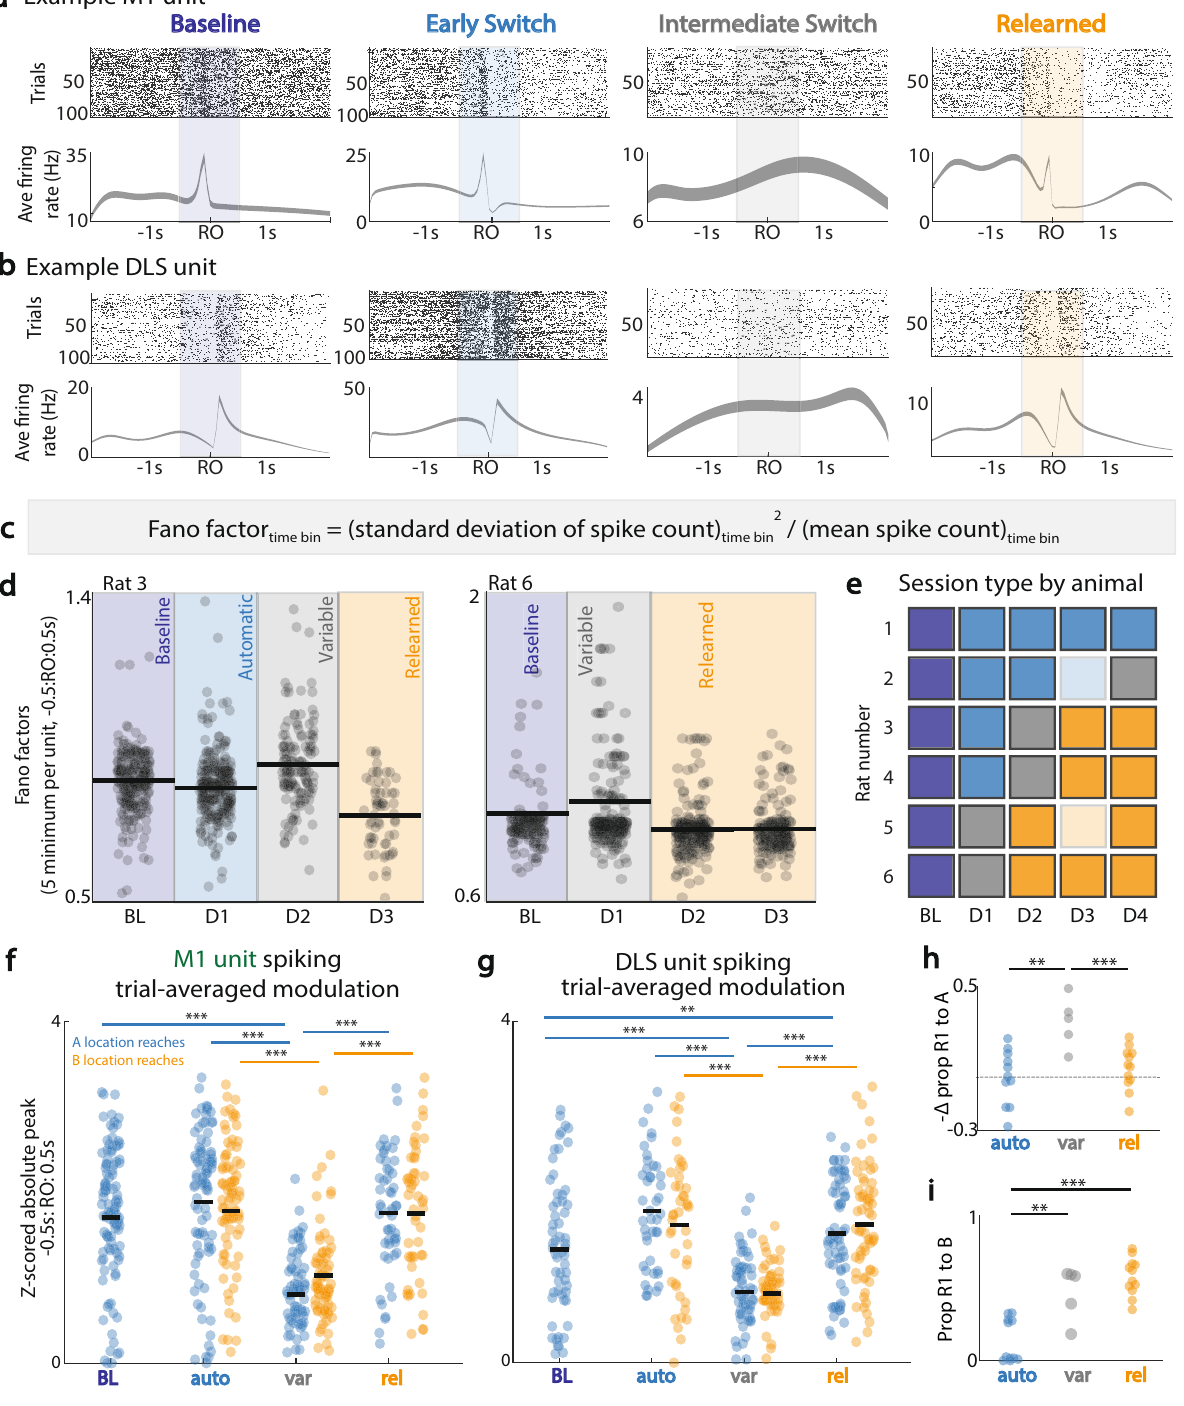
Fig. 2 Breakdown of reach-locked M1 and DLS unit spiking during exploration. a Top: Rasters for a single M1 unit † across sessions (same channel across days). Bottom: trial-averaged fi ring rate (mean ± SEM) for − 2 s to 2 s around fi rst reach onset. b Same as ( a ), for a DLS unit. † c Equation for determining Fano factor per time bin for each unit, per session. d Five minimum Fano factors per unit for − 0.5 s to 0.5 s around fi rst reach onset, across representative sessions, for two example animals. e Session type re-categorization based on Fano factors: indigo = baseline, blue = automatic (post-switch, no Fano factor change), gray = variable (maximum increase in Fano factor), orange = relearned. Light blue/light orange = two sessions not analyzed because of data corruption during recording. f M1 unit peak trial-averaged modulation around reach onset for trials with fi rst reach to A (blue dots) and for trials with fi rst reach to B (orange dots), across session types; peak modulation was calculated after z-scoring unit fi ring across the session. g Same as ( f ), for DLS units. h Change in proportion of fi rst reach to A in a session, relative to proportion of fi rst reach to A in previous session; grouped by session type across all animals, all sessions. i Proportion of fi rst reach to B in a session, grouped by session type across all animals, all sessions. † Unit may not be the same across sessions. *<0.05, **<0.01, ***<0.001, linear mixed effects model, Bonferroni-corrected signi fi cance. Source data are provided as a Source Data fi